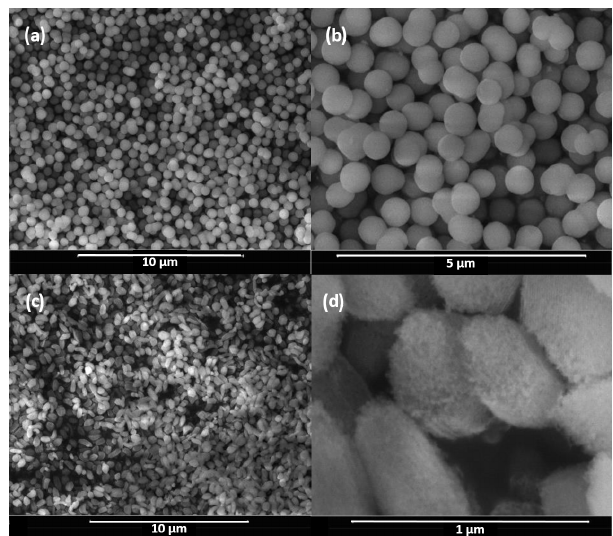
Figure 1. Scanning election microscopy images of (a, b) 2.8H2 as an example of MCM-41 particles and (c, d) 9.0M2 as an example of SBA-15